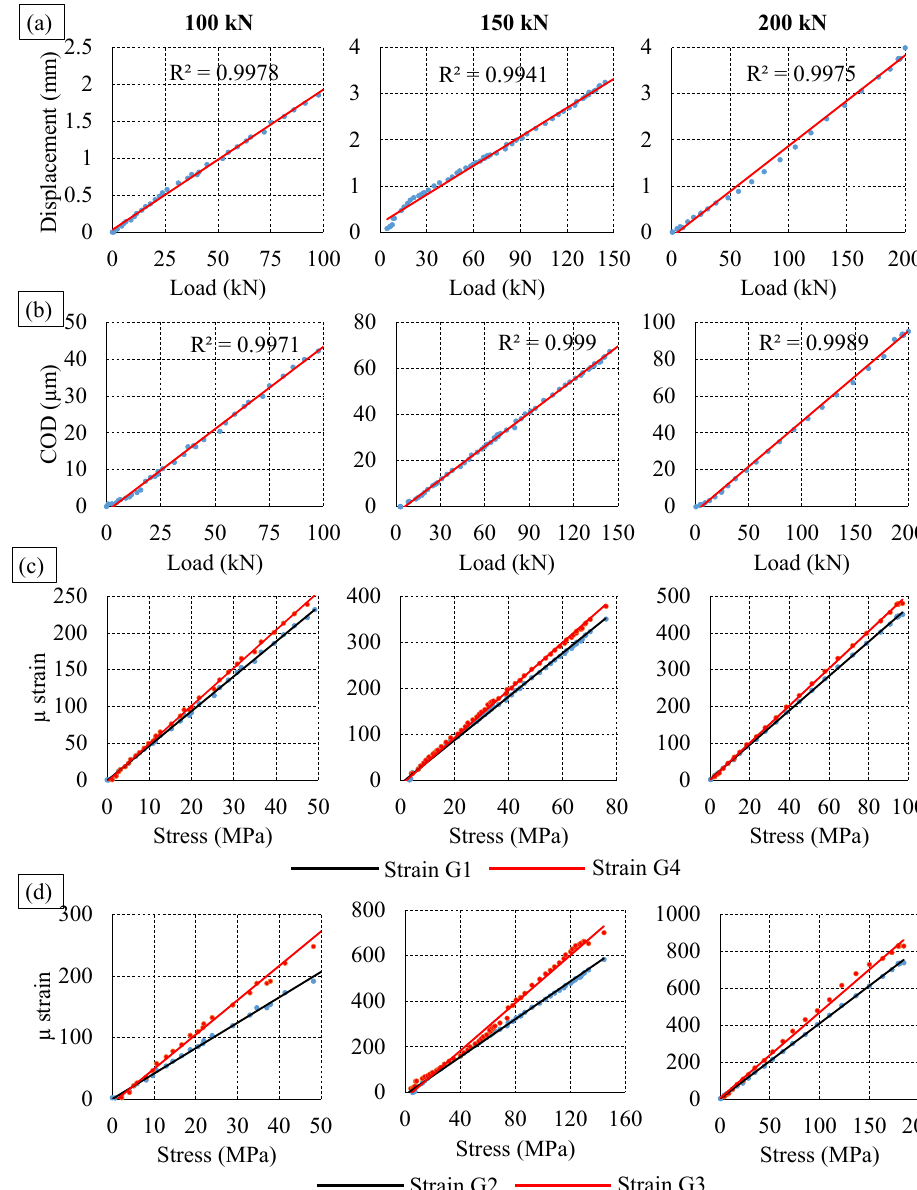
Figure 8. Recorded AE hits and load with respect to normalised time. ( a ) 100 kN, ( b ) 150 kN ( c ) 200 kN.